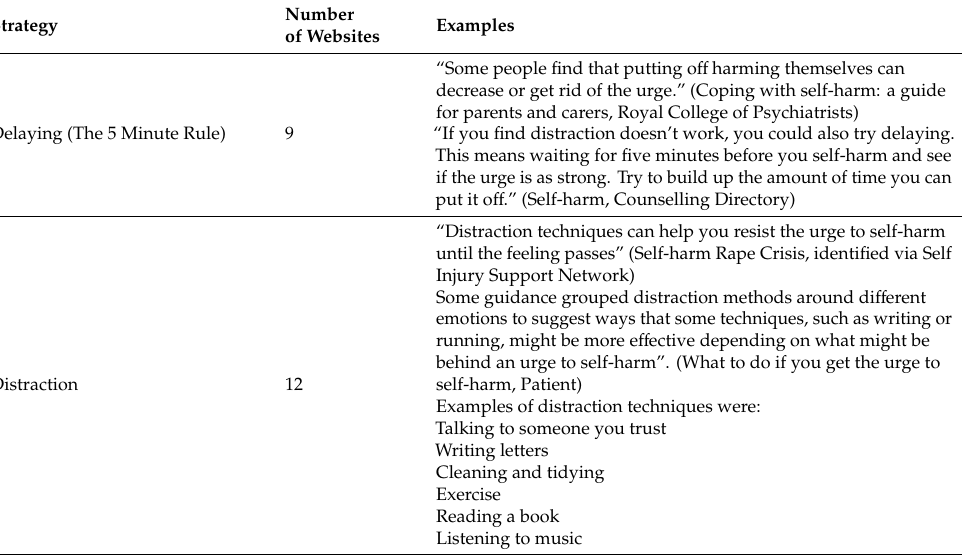
Table 2. Strategies to help avoid imminent